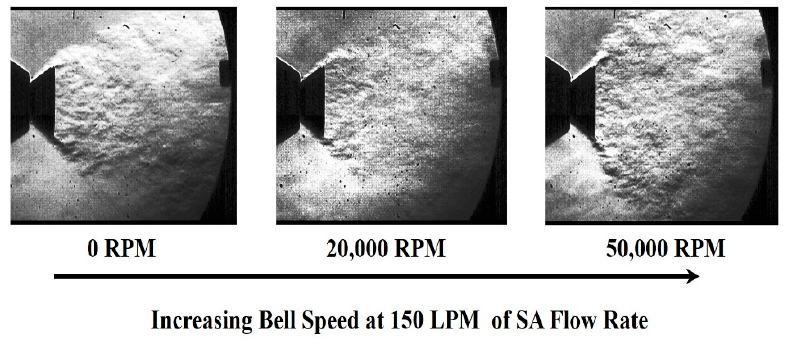
Figure 6. Schlieren images of the ERBS SA, with changing bell cup rotational speeds at a fixed SA flow rate of 150 LPM.